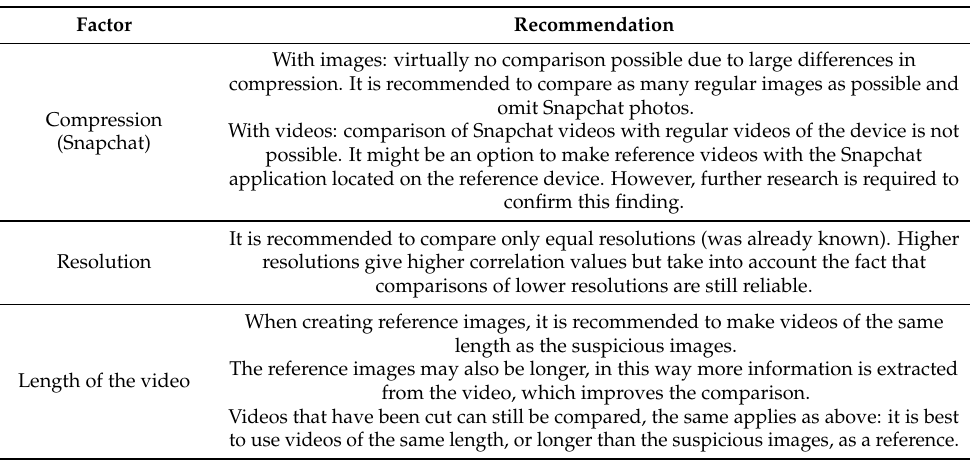
Table 6. Overview of recommendations for implementation per factor